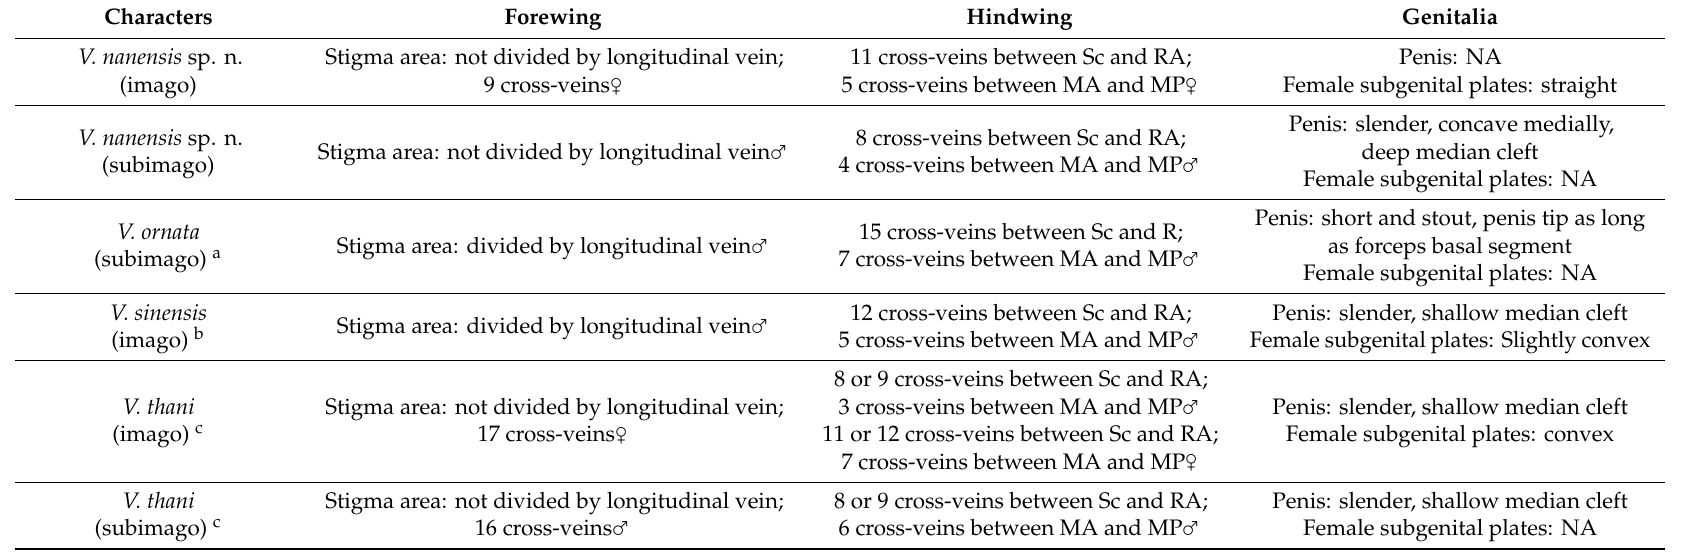
Table 4. Comparison of adult characteristics of known Vietnamella